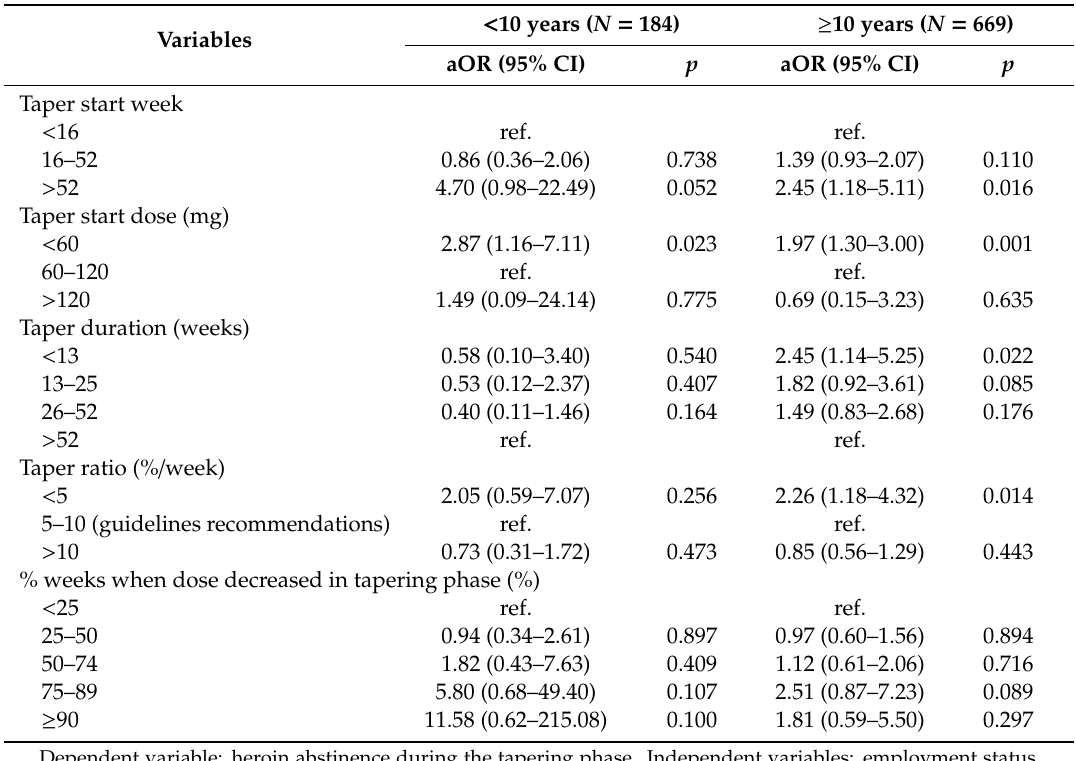
Table 5. Subgroup analyzes of the e ff ect of variables on heroin abstinence in di ff erent years of drug abuse before enrolment in